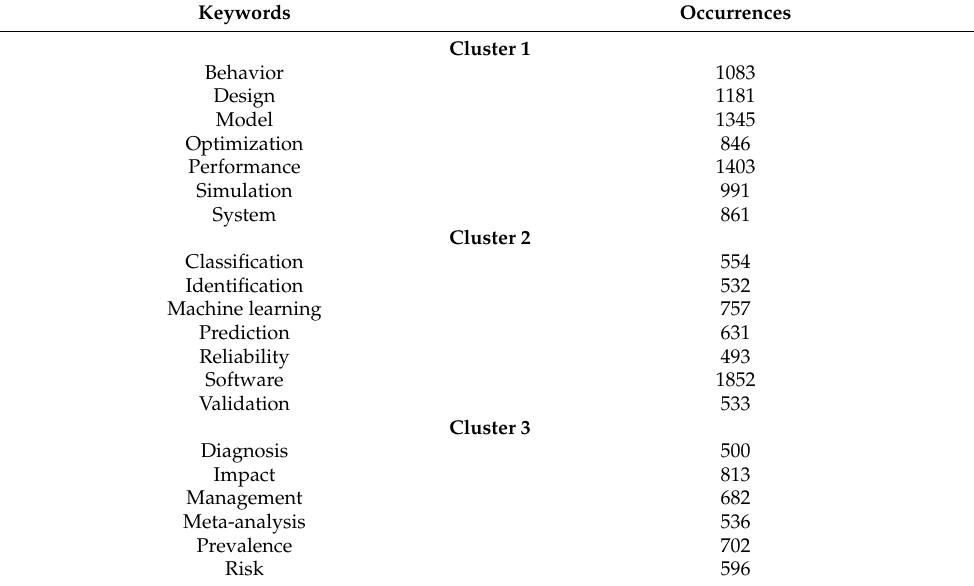
Table 16. Number of occurrences of top 20 Keywords in each cluster for the years